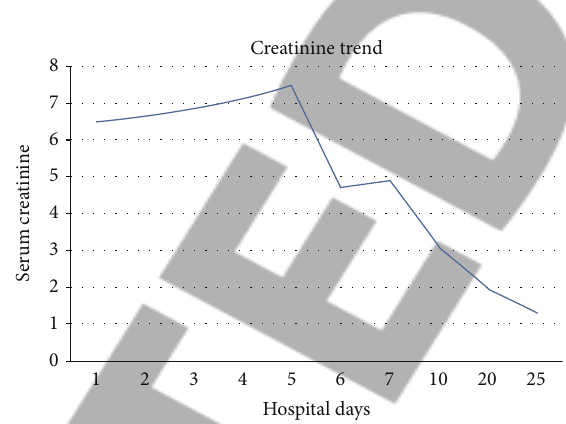
Figure 1: Immunofluorescence staining shows linear GBM staining for IgG consistent with Goodpasture’s disease.